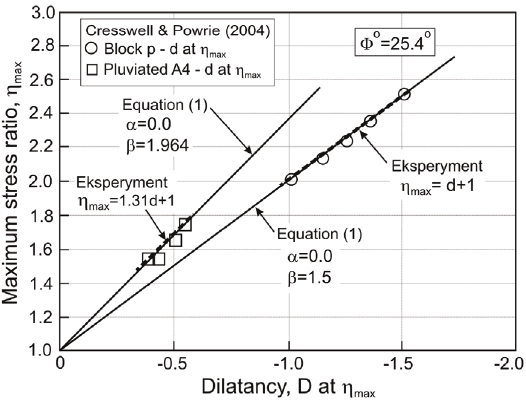
Fig. 8. Maximum stress ratio and dilatancy at failure for Reigate silver sand